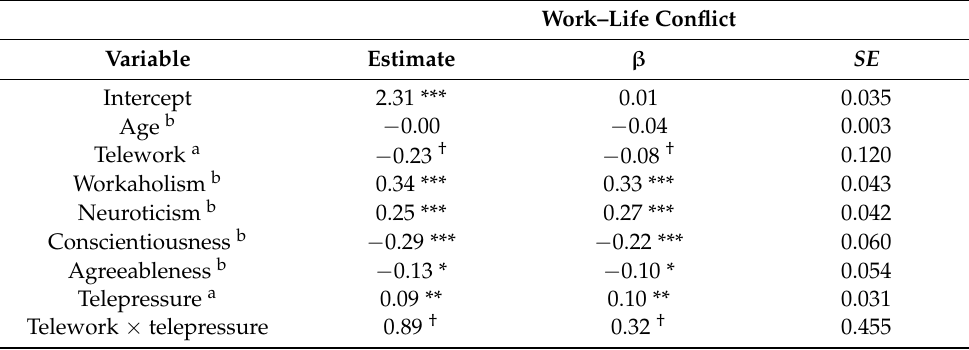
Figure 2. Interaction effect of telework and telepressure on work–life conflict. Table 5. Multilevel multiple regression results predicting work–life